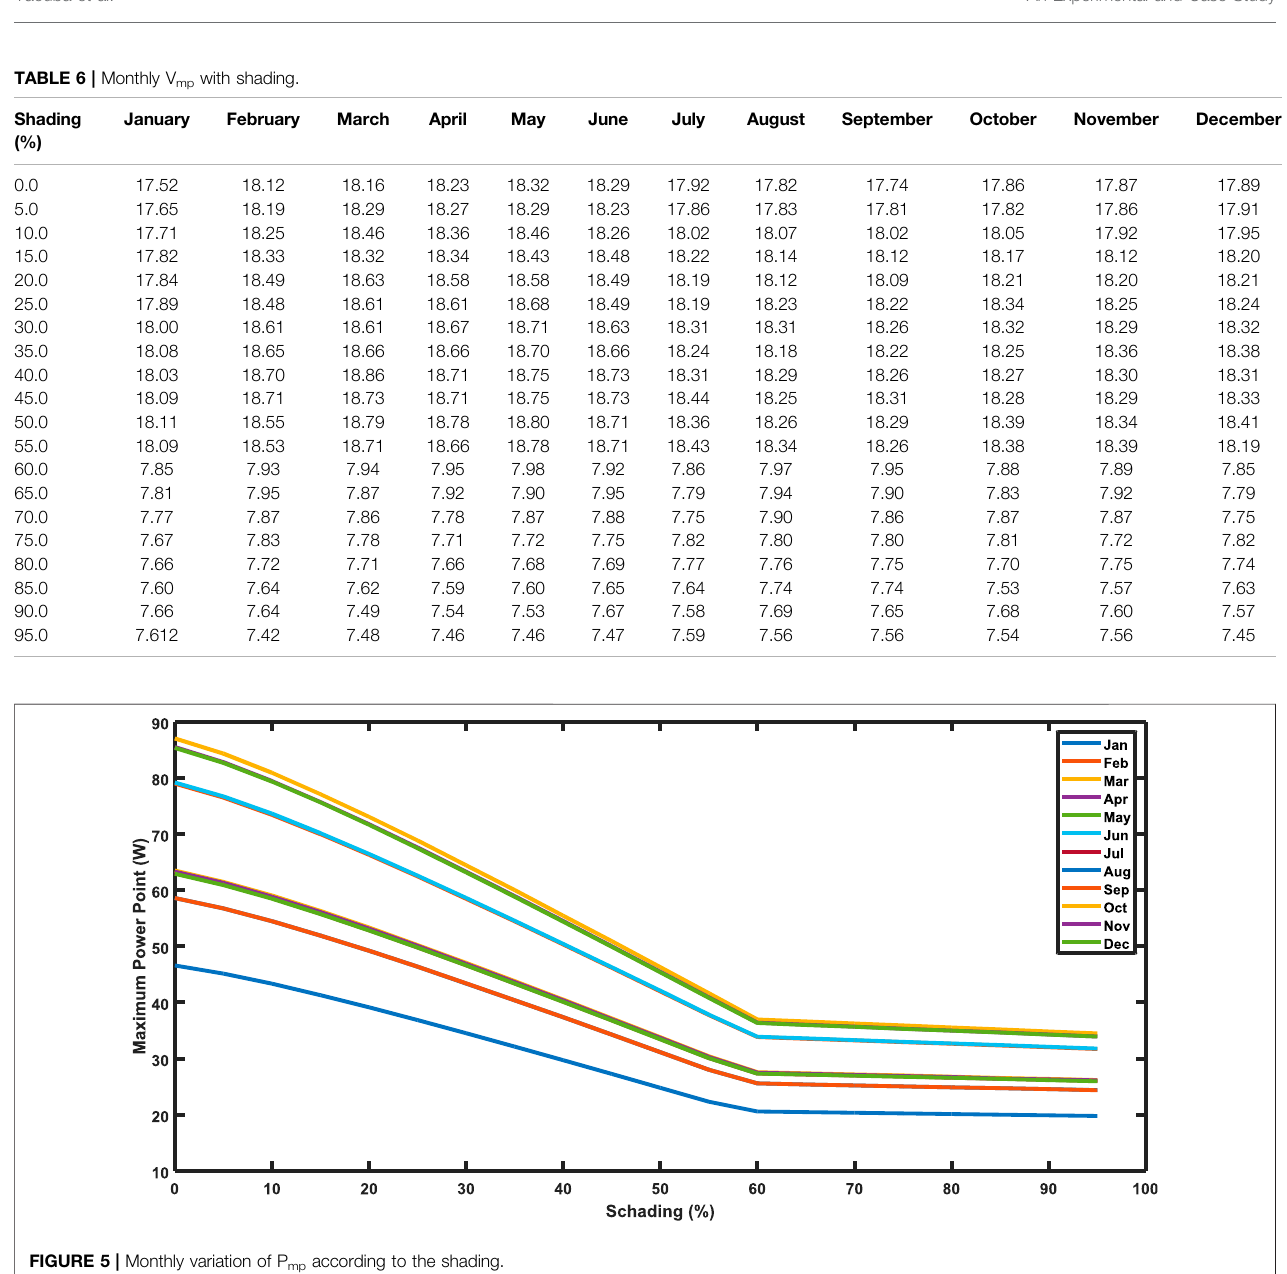
FIGURE 5 | Monthly variation of P mp according to the shading.